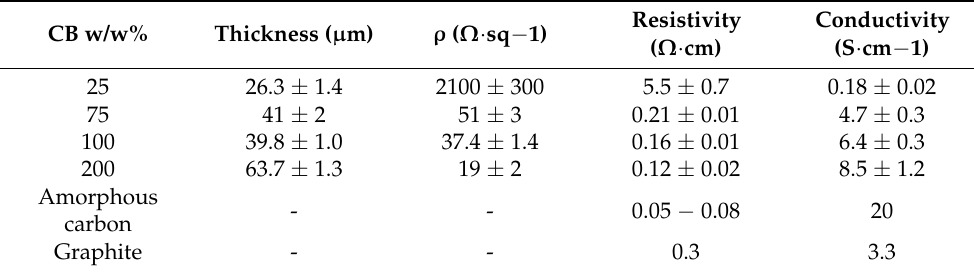
Table 1. CH-CB membrane electrical properties. Standard deviation is given for five different membranes. Electrical properties for amorphous carbon and graphite are also given [41].